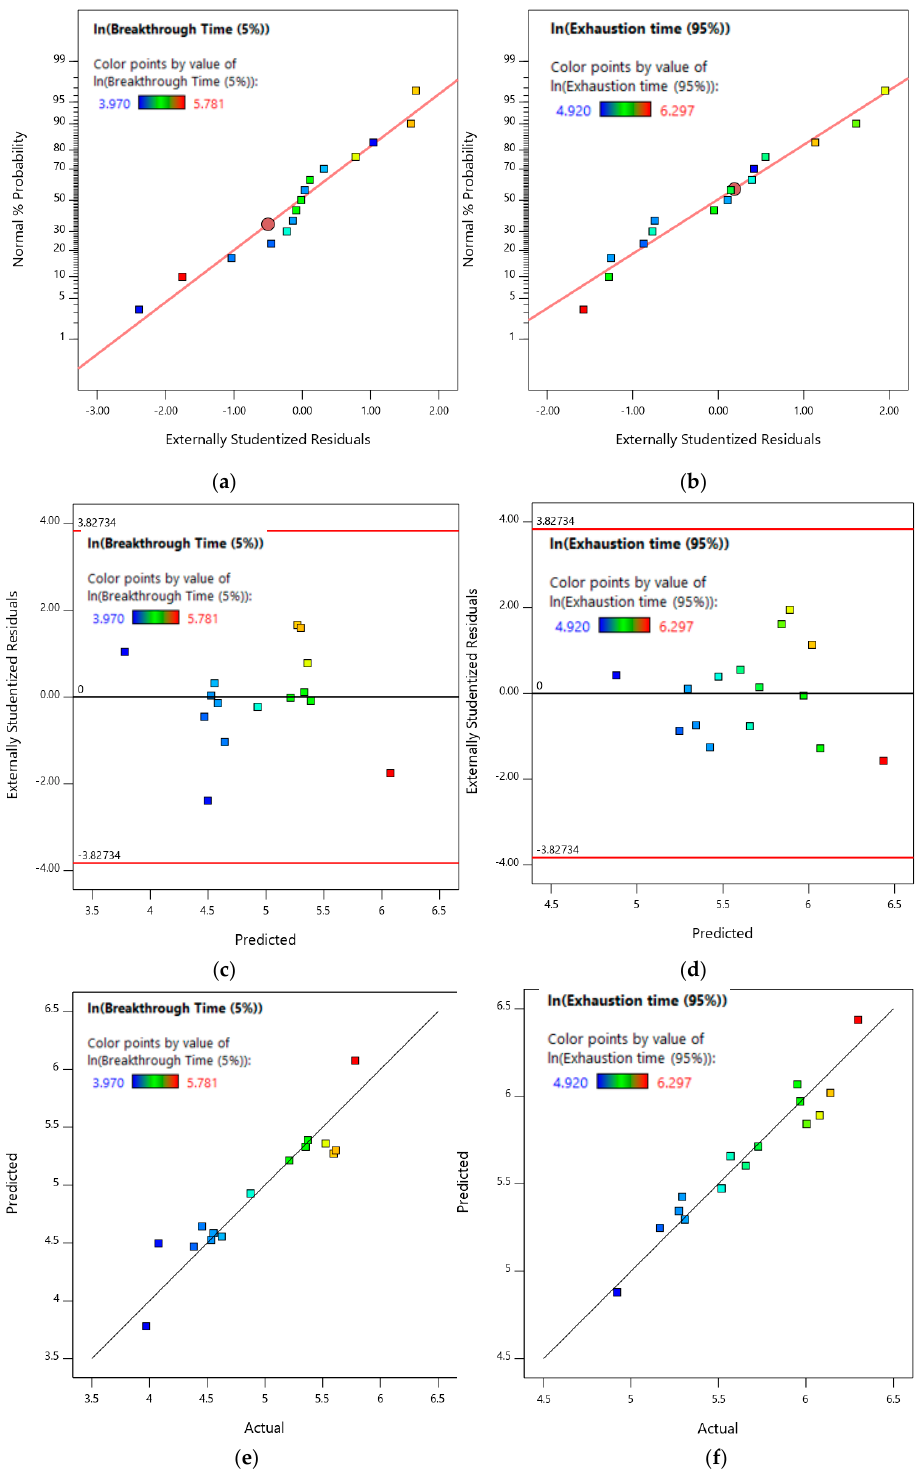
Figure 6. ( a ) Normal plot of residuals for reduced quadratic toluene breakthrough model. ( b ) Normal plot of residuals for reduced quadratic toluene exhaustion model. ( c ) Residual vs. predicted plot for reduced quadratic toluene breakthrough model. ( d ) Residual vs. predicted plot for reduced quadratic toluene exhaustion model. ( e ) Predicted vs. actual plot for reduced quadratic toluene breakthrough model. ( f ) Predicted vs. actual plot for reduced quadratic toluene exhaustion